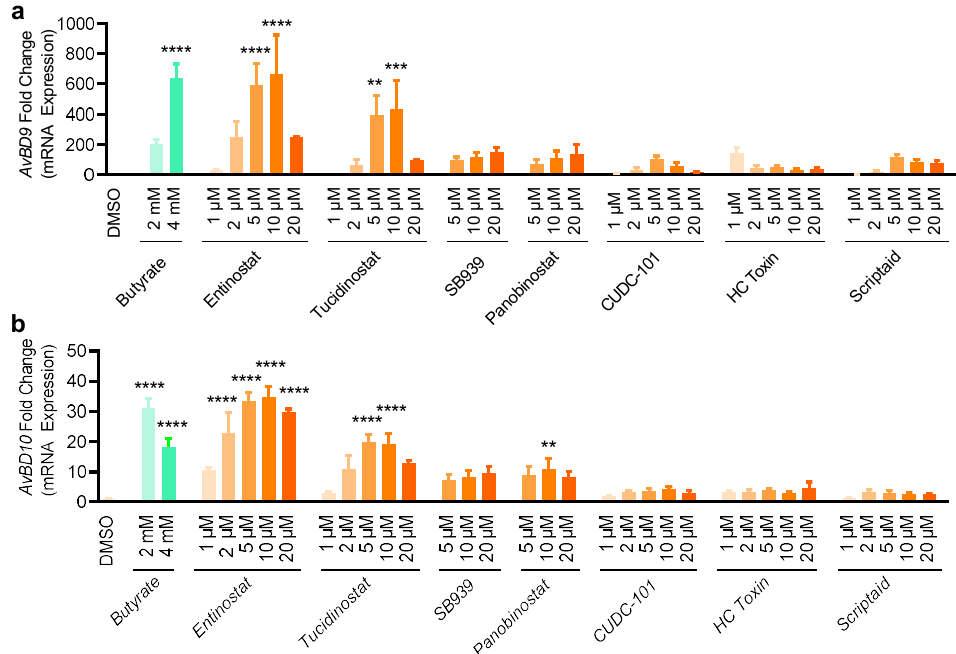
Figure 5 . Induction of the AvBD9 and AvBD10 mRNA expression by seven selected compounds in chicken HD11 macrophages. HD11 cells were stimulated in duplicate with indicated concentrations of each compound for 24 h, followed by RT-qPCR of AvBD9 ( a ) and AvBD10 ( b ) expression. Fold changes were calculated relative to DMSO-treated cells using the ΔΔCt method. The results are means ± SEM of 3–4 independent experiments. ** p < 0.01, *** p < 0.001, and **** p < 0.0001 relative to the DMSO control (by one-way ANOVA and post-hoc Dunnett’s multiple comparisons test).